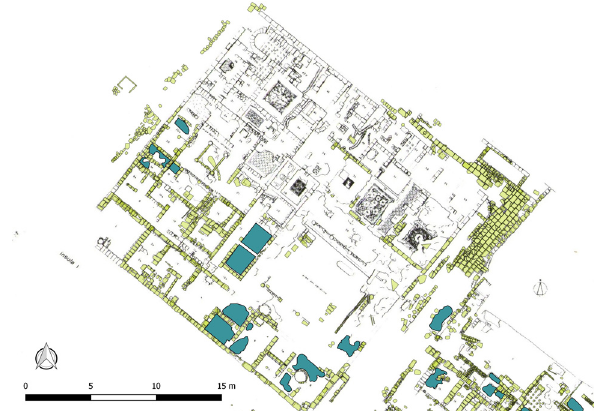
Figure 20. Overlap of an old plan of the Insula I on the new